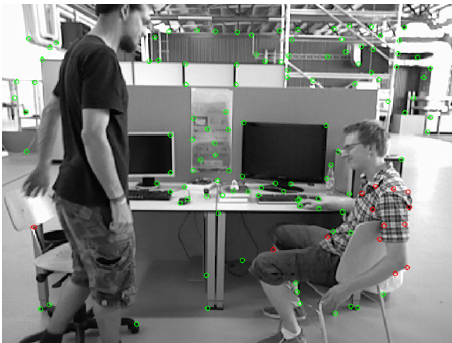
Figure 7. Screenshot obtained from sequence F3W. Points labeled as outliers are circled in red, whereas green circles represent inliers used to update camera